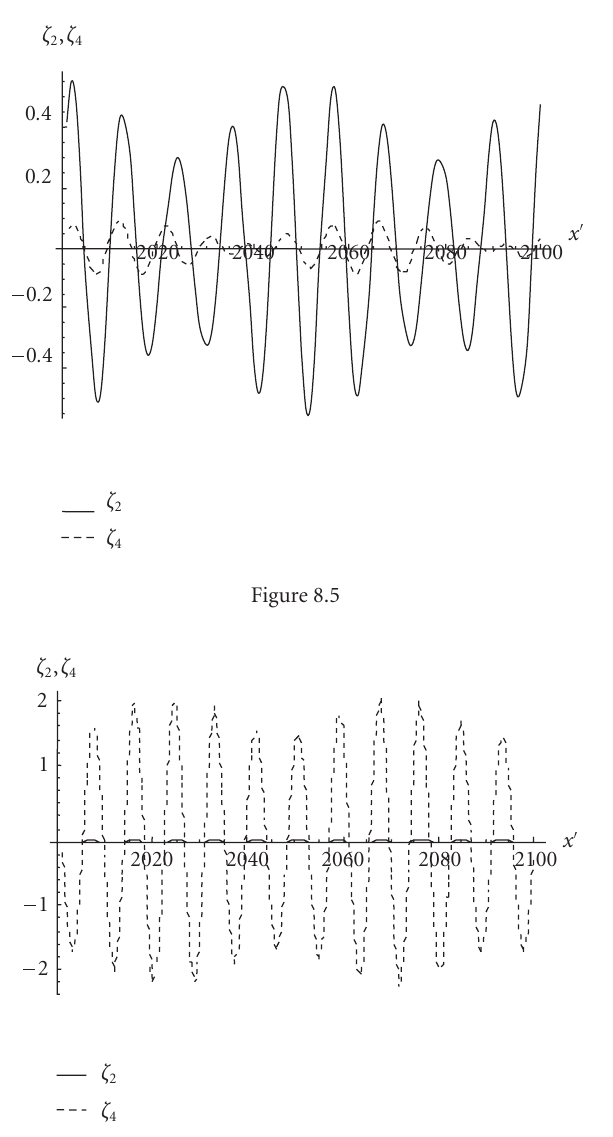
√ ×√ 10, u (cid:6) 0 = (1 / 10) ×